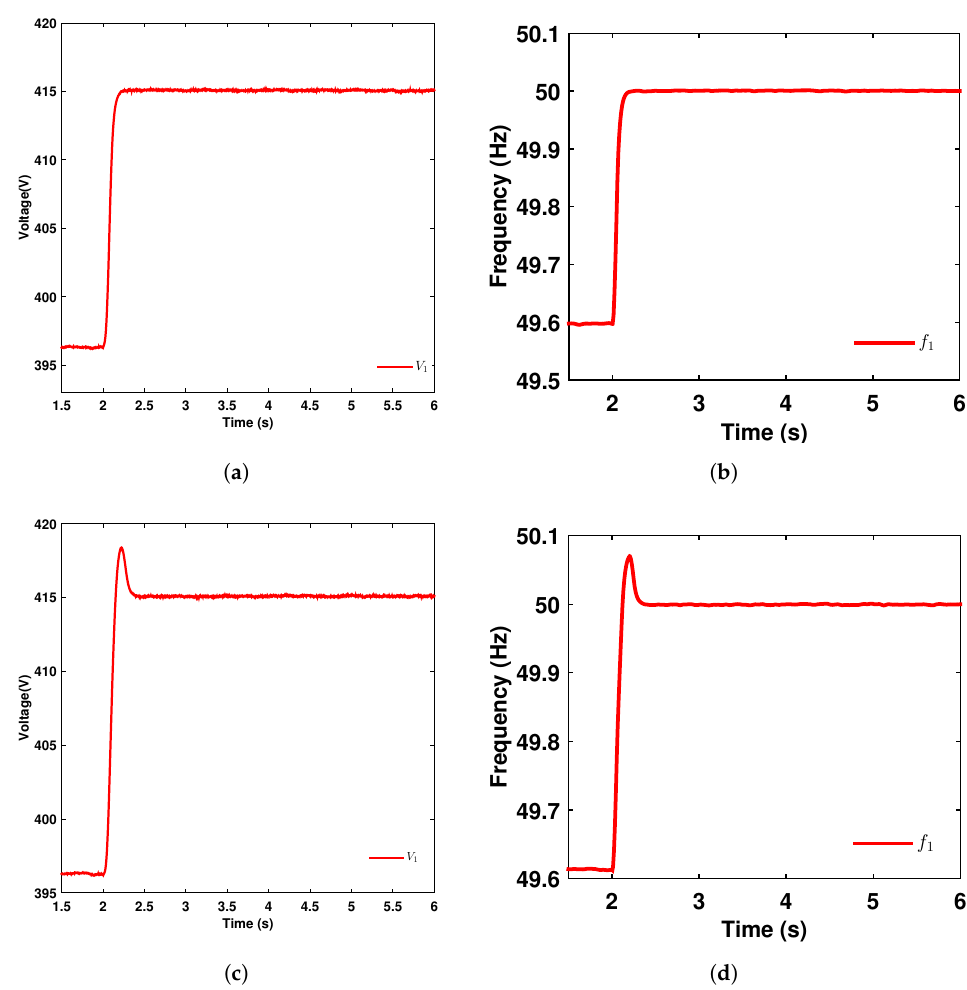
Figure 9. Performance with data dropout. ( a ) Voltage every 30 ms. ( b ) Frequency every 30 ms. ( c ) Voltage every 10 ms. ( d ) Frequency every 10 ms.